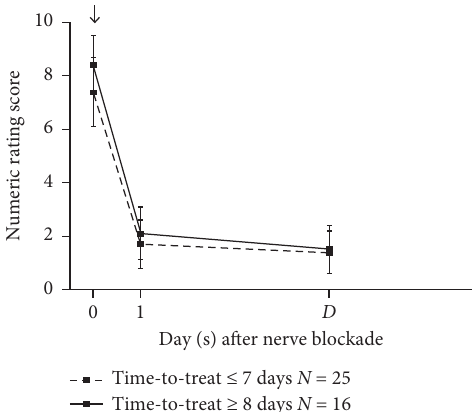
Figure 2: Numeric rating scores for the time-to-treat. Data at each time point were presented with mean and standard deviation. blockade. ↓ : occipital nerve blockade. Interaction concerning time-